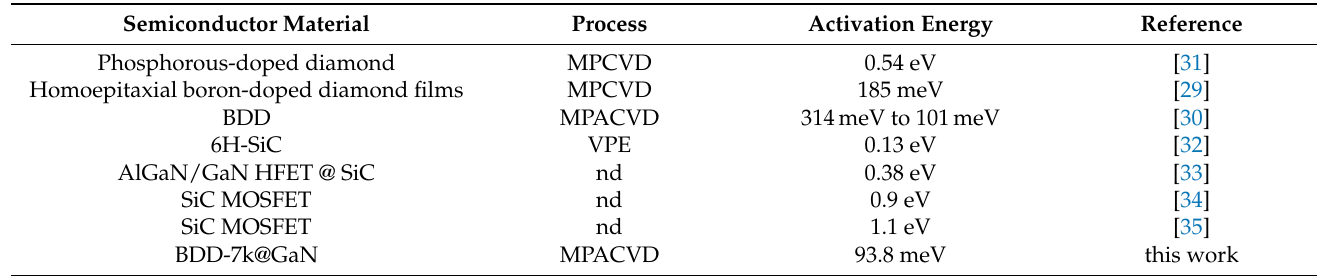
Table 3. Comparison of the activation energy for different semiconductor